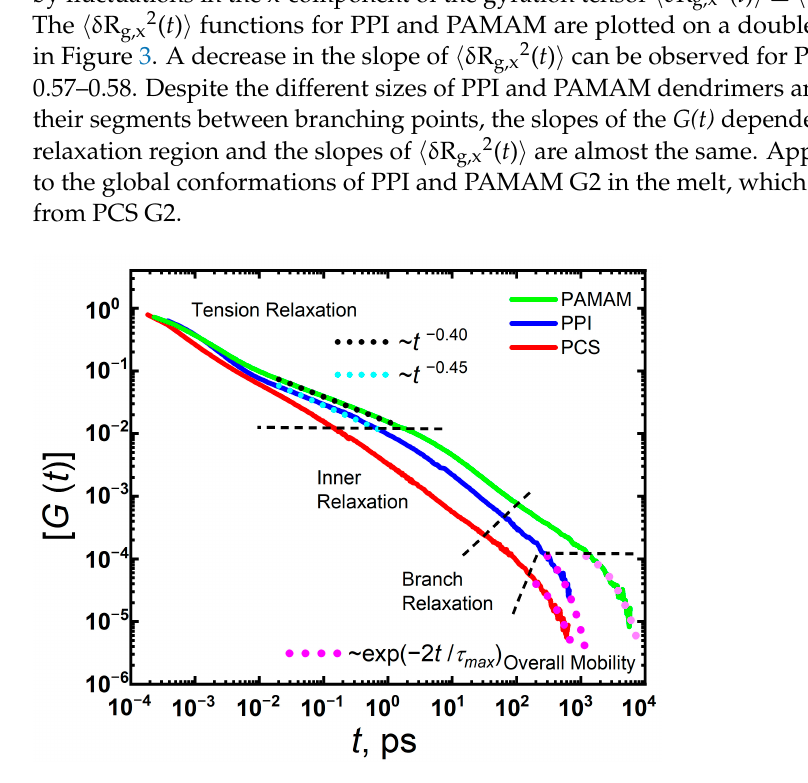
Figure 2. Double-logarithmic representation of the normalized shear-stress relaxation moduli [ G(t) ] = G(t)/G(0) for PAMAM and PPI dendrimer melts. For comparison the data for PCS melt are adapted with permission from Ref. [40]. 2019, American Chemical Society.